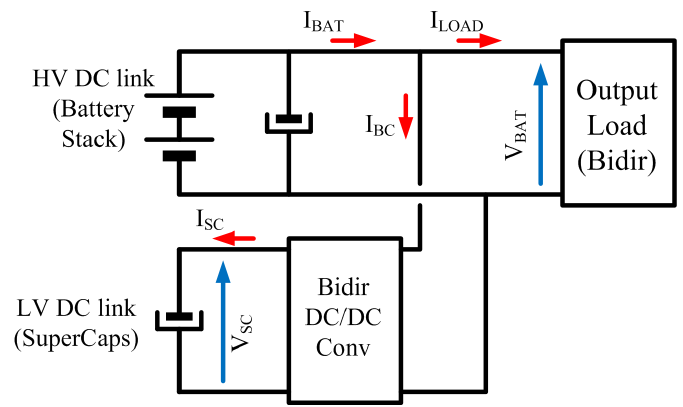
Figure 1. Parallel configuration for interfacing supercapacitors (SCs) with primary energy source (battery